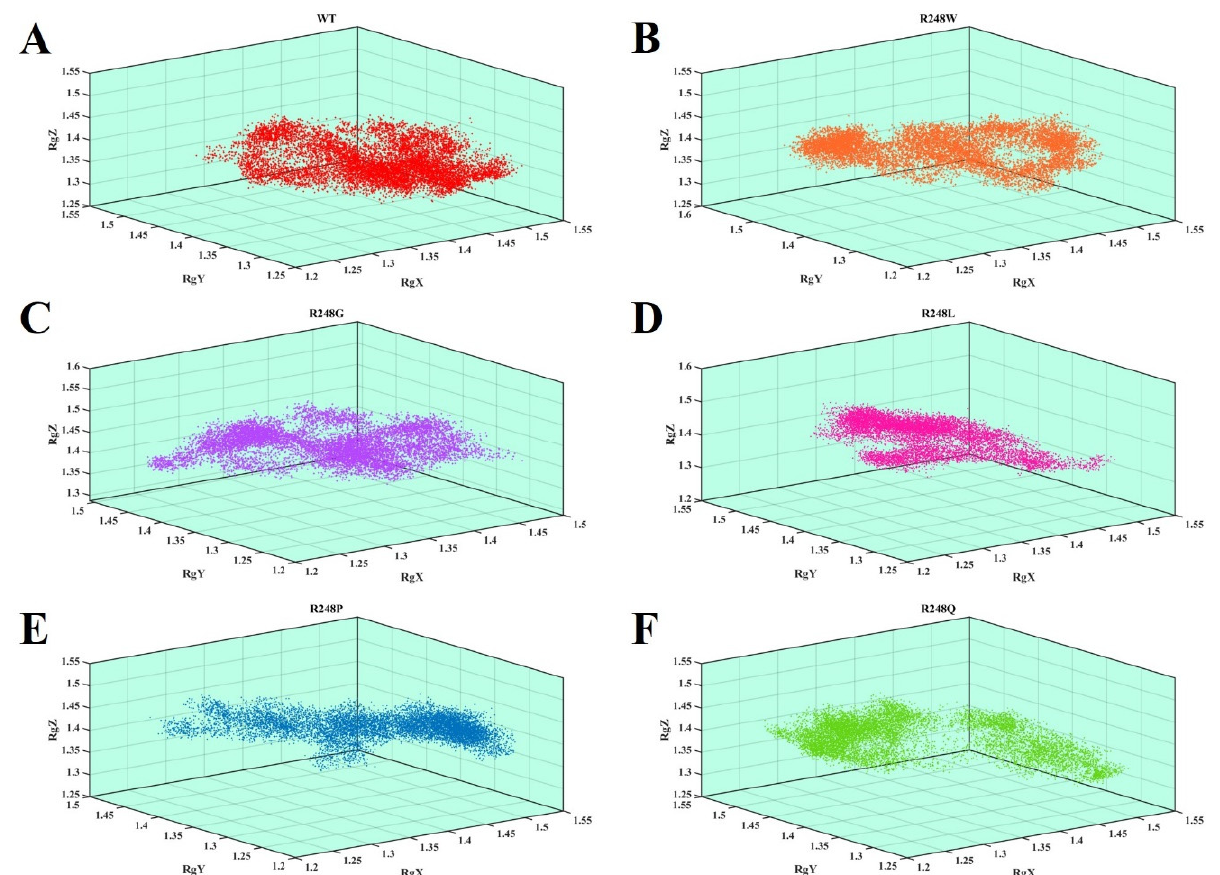
Figure 4. The 3D scatter radius of gyration (Rg) plot of the wt-p53–DNA and R248 mutant-p53–DNA complexes. The X and Y axes denote time (ns) and the number of Rg (nm). ( A ) The red color represents the wt-p53–DNA complex, ( B ) the orange color represents the R248W mutant-p53–DNA complex, ( C ) the violet color represents the R248G mutant-p53–DNA complex, ( D ) the pink color represents the R248L mutant-p53–DNA complex, ( E ) the blue color represents the R248P mutant-p53–DNA complex, and ( F ) the green color represents the mutant R248Q mutant-p53–DNA complex.